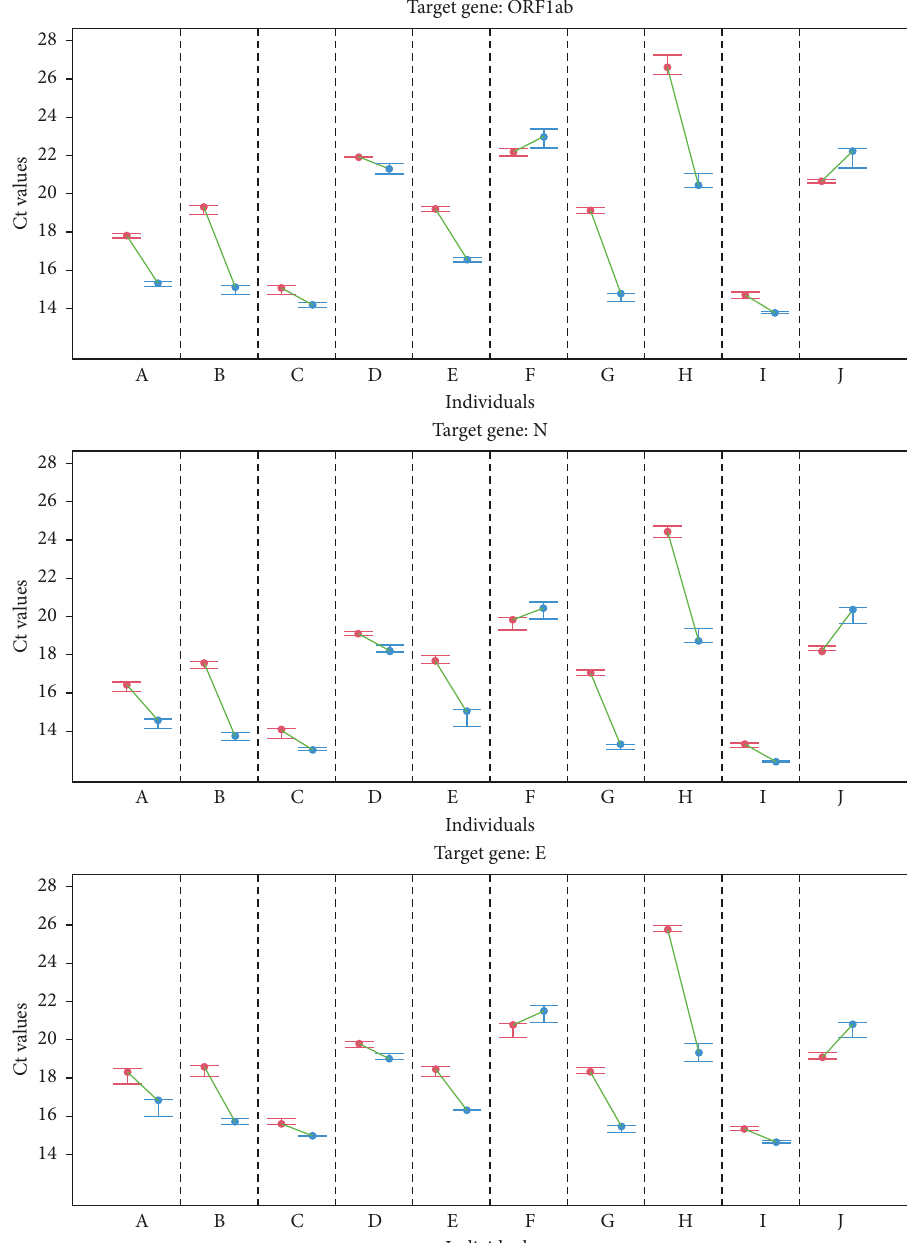
Figure 3: Minimum and maximum (bars) and median (points) Ct values after heating for 5 min (red) and 15min (blue). Green segments represent variation in Ct median values due to differences in heating. Letters A to J refer to identification of 10